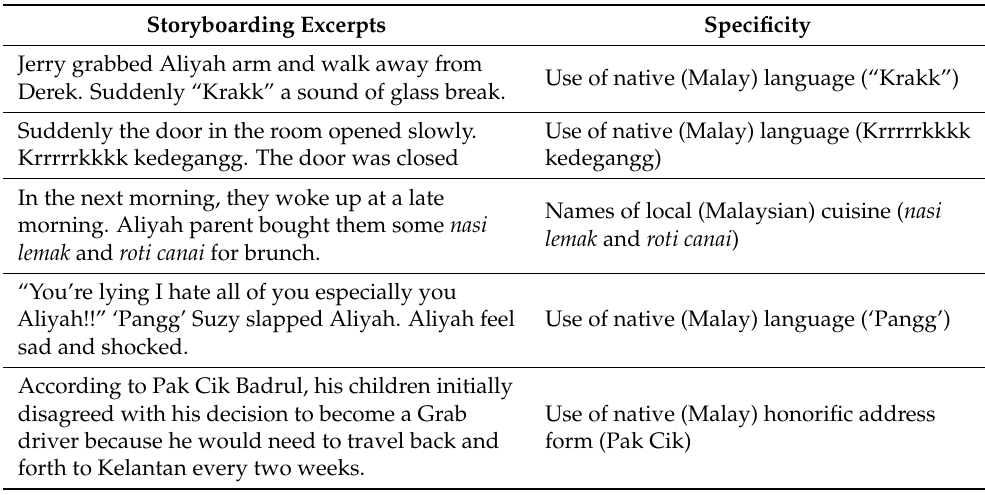
Table 10. Collocal Vocabulary and Expressions in